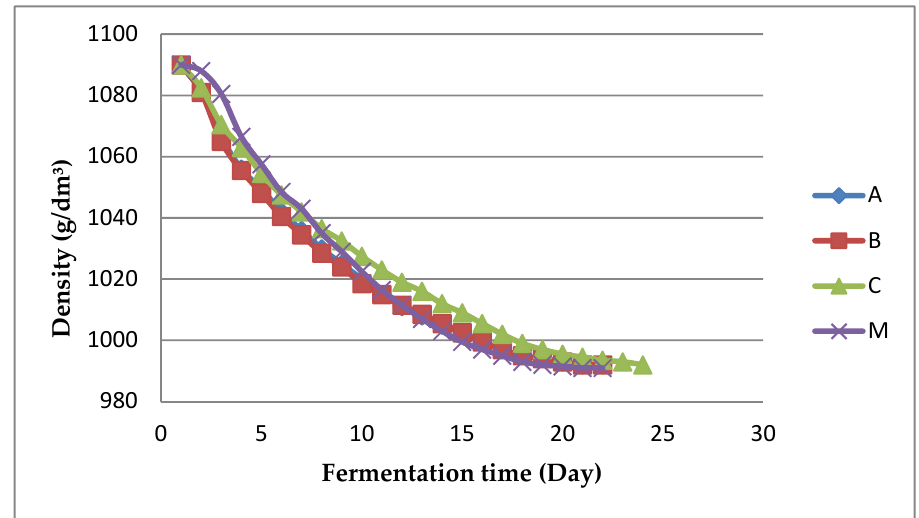
Figure 1. Density evaluation of four experimental Merwah wines during alcoholic fermentation at the winery Ch â teau Bybline. A: wine inoculated by the strain M.6.16; B: wine inoculated by the strain M.10.16; C: wine inoculated by the strain M.4.17; M: wine fermented spontaneously (control).